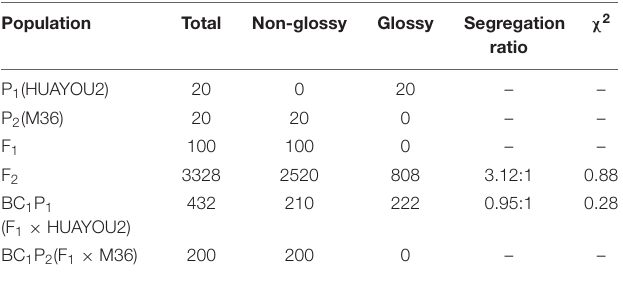
TABLE 2 | Segregation of glaucous and glossy traits and the χ 2 goodness-of-fit test of segregation in BC 1 P 1 and F 2 populations. Population Total Non-glossy Glossy